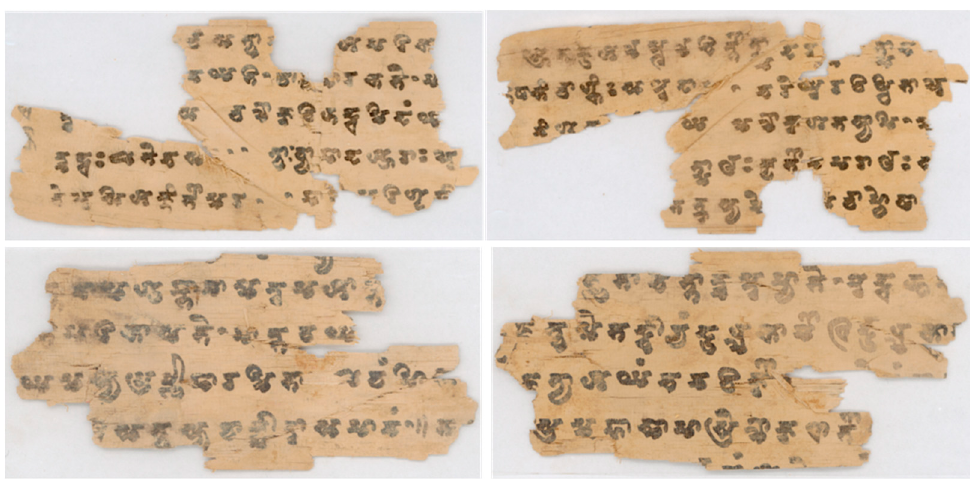
Figure A1. The recto and verso scans of MS 2381/11 ( top ) and MS 2381/146 ( bottom ).